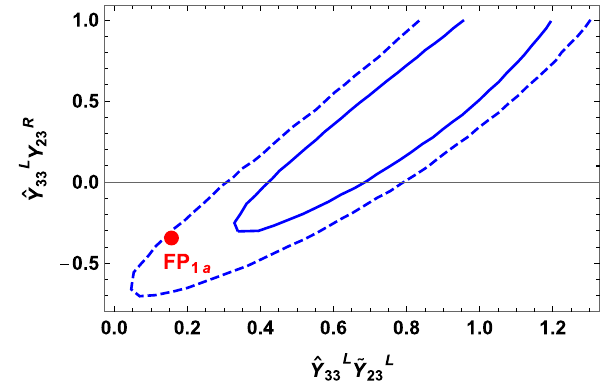
Fig. 6 Solid (dashed) blue line gives the 1 σ (2 σ ) confidence region of the b → c global fit of Ref. [118] in the plane ( ˆ Y L S 1 Yukawa couplings at m S of FP 1